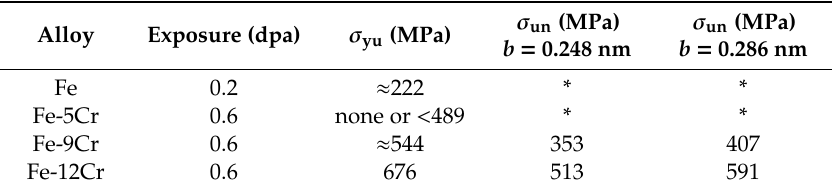
Table 4. Upper yield stress, σ yu , derived from positive (‘yes’) or limit cases in Table 2, and unlocking stress, σ un , derived from Equation